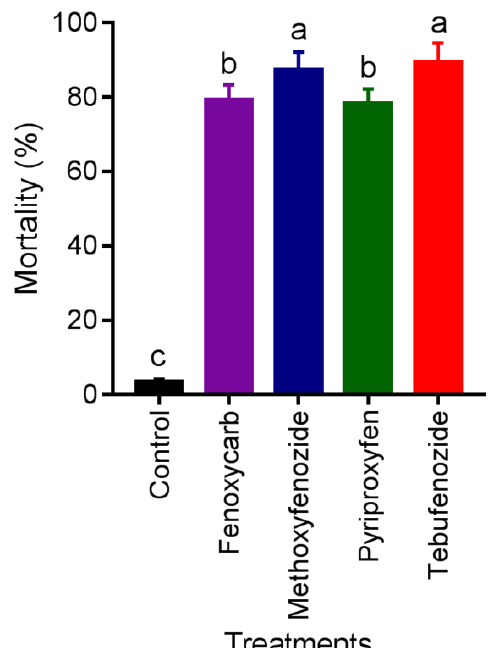
Figure 3. Mortality (mean ± SEM) of Euprosterna elaeasa larvae caused by insect growth regulators (IGRs) applied on oil palm leaves in field conditions. Treatments means with different letters show significant differences by Tukey’s HSD test at the p < 0 . 05 level.